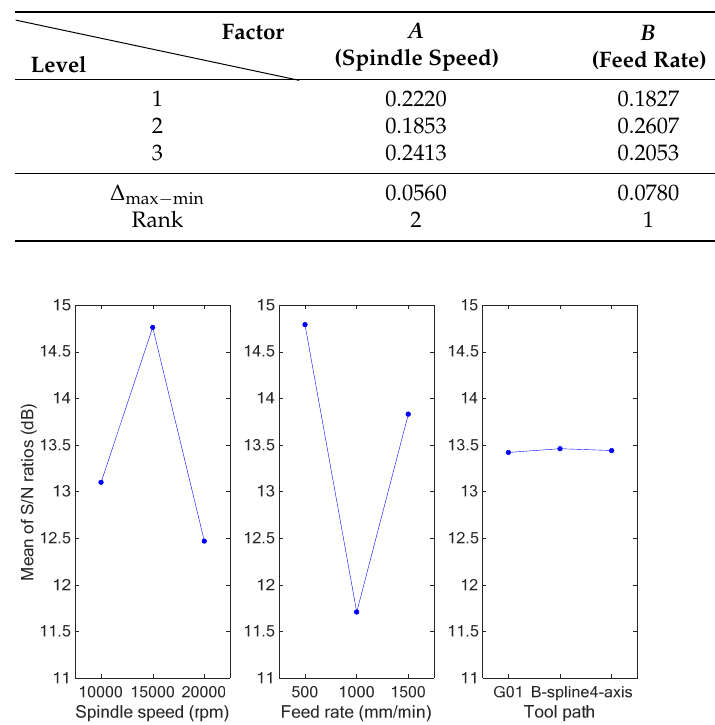
Figure 20. Graph of S/N ratios for surface roughness.